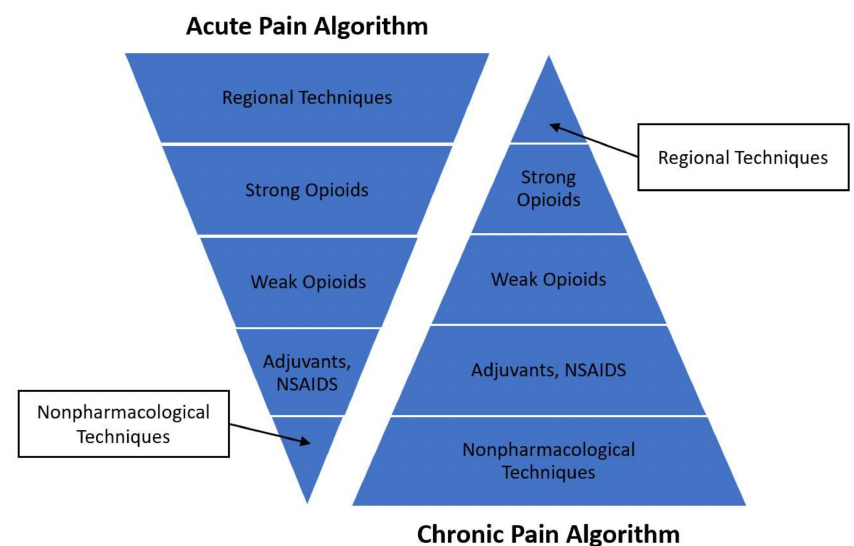
Figure 2. Multidisciplinary pain management: acute and chronic pain algorithms. In acute pain algorithms, the initial treatment begins with regional techniques or intravenous analgesia as a mainstay of therapy. As acute pain improves, therapies are then transitioned as appropriate to varying strengths of PO opioid medications, to adjuvants/NSAIDS, and ultimately integrative non-pharmacological strategies. For situations where severe pain is anticipated, adjuvants and integrative non-pharmacological strategies may be added on at the beginning of treatment, as an opioid sparing strategy, and to increase patient comfort. In chronic pain algorithms, treatment is delivered in the reverse order, beginning with integrative non-pharmacological techniques, then moving to adjuvants, and ultimately progressing to various strengths of opioids and regional techniques and stimulators as clinically